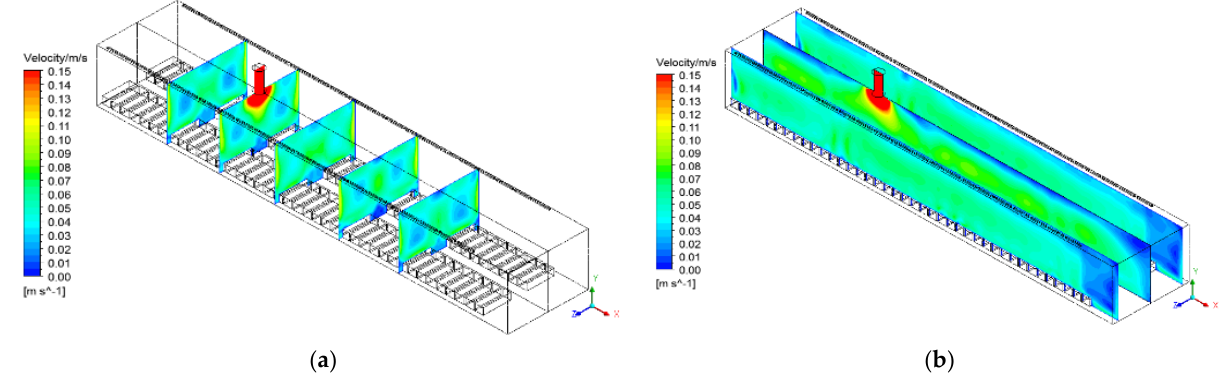
Figure 8. Velocity distribution in different ( a ) longitudinal and ( b ) horizontal